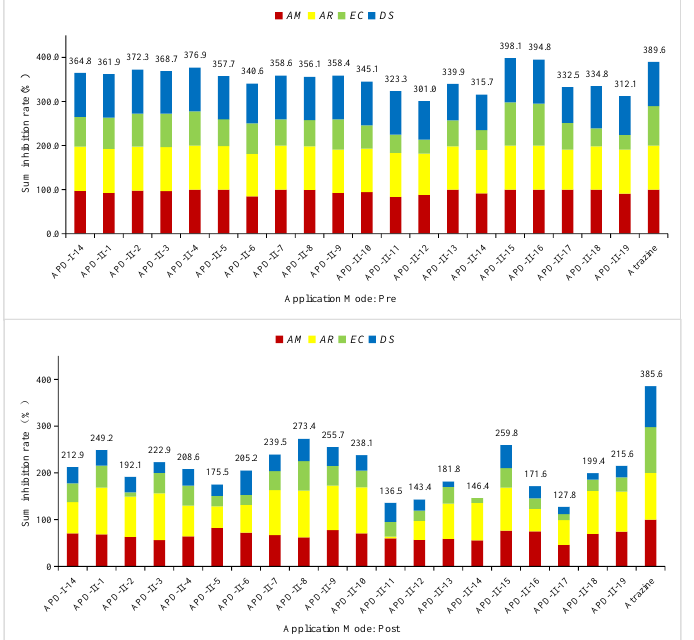
Figure 4. Effects (% inhibition) of compounds APD-I-14 , APD-II-1 – APD-II-19 on loss of plant weight at a dosage of 1500 g ha − 1 after treatment at 14 days (Pre) or 21 days (Post); Pre—pre-emergence condition; Post—post-emergence condition; Abutilon theophrasti Medicus (AM), Amaranthus retroflexus L. (AR), Echinochloa crus-galli (EC) and Digitaria sanguinalis (L.) Scop. (DS).